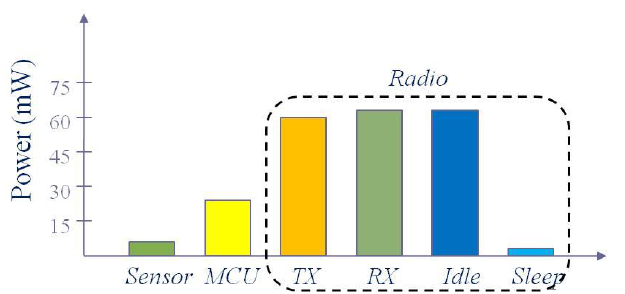
Figure 1. Power consumption of a MicaZ node